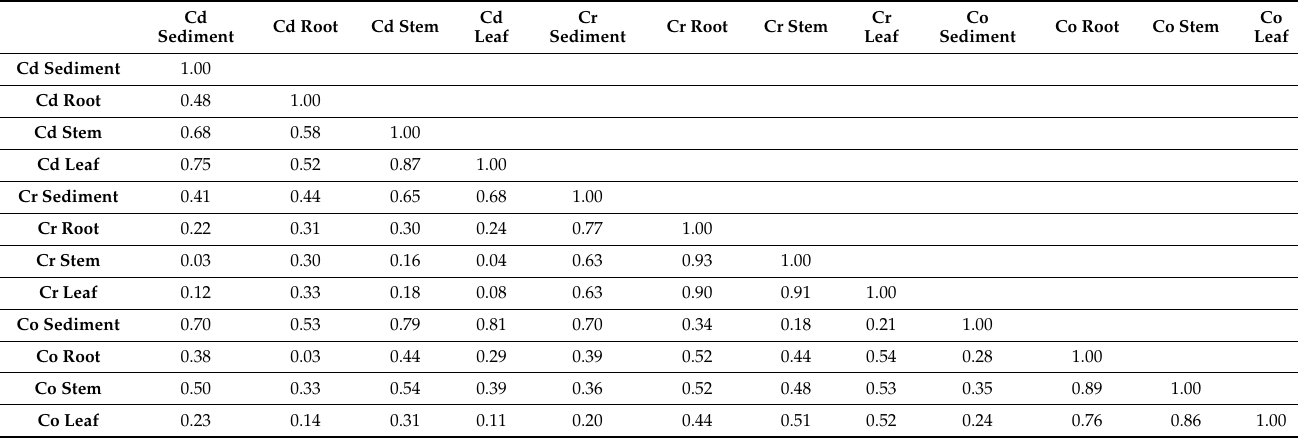
Table 6. Pearson’s correlation